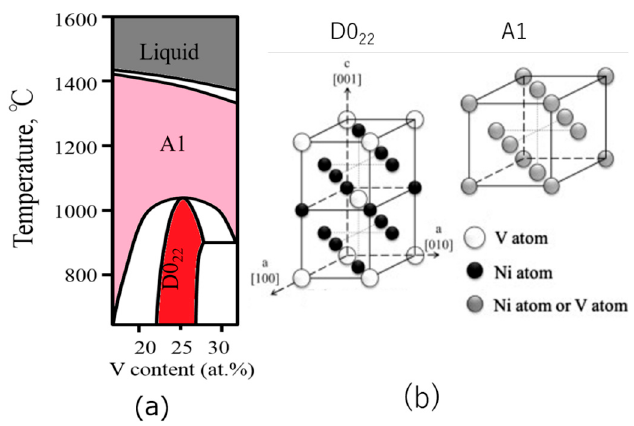
Figure 16. ( a ) Phase diagram of Ni-V binary alloy near the V concentration of 25% and ( b ) crystal structures of D0 22 (tetragonal) and A1 (fcc).